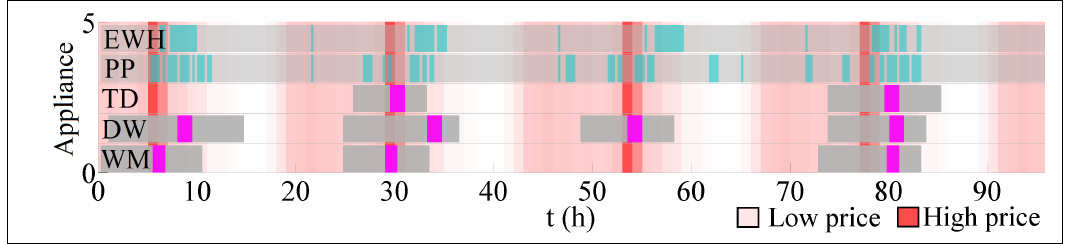
Figure 8. The DE and IN appliance cycles for the first 96 simulation